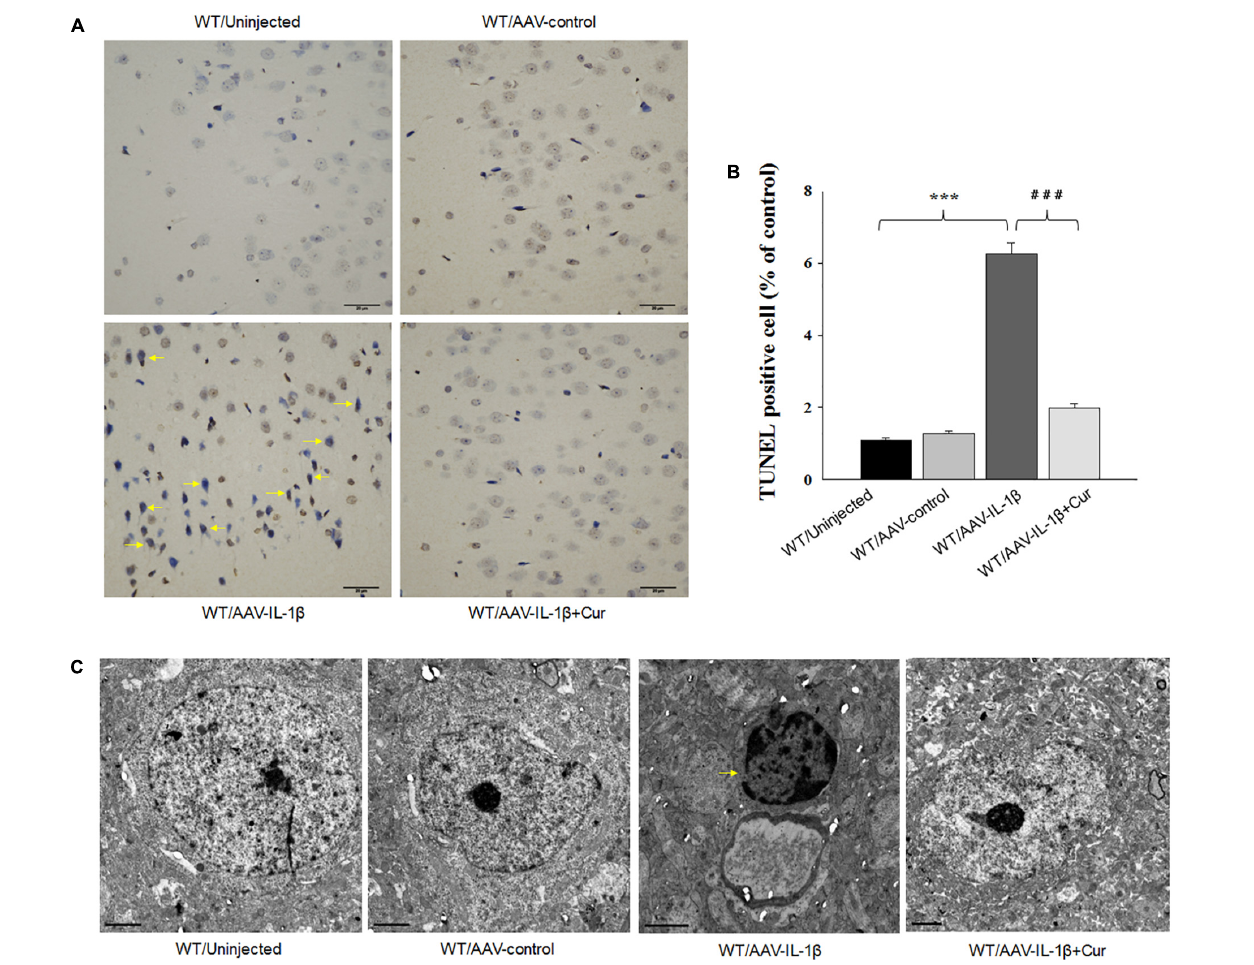
FIGURE 5 | Overexpression of IL-1 β within the vmPFC leads to neuronal apoptosis within the vmPFC of normal wild type rats. (A) TUNEL positive apoptotic cells (indicated by the arrows) in vmPFC regions infected with AAV-IL-1 β . (B) Histograms showing the increased TUNEL positive cells caused by AAV-IL-1 β infusion were significantly attenuated by curcumin treatment. (C) Nuclear chromatin abnormalities in vmPFC neurons infected with AAV-IL-1 β . Arrows indicate nuclear chromatin aggregation, condensation and margination. N = 6/group. ∗ P < 0.05, ∗∗ P < 0.01, ∗∗∗ P < 0.001 WT + AAV-IL-1 β vs. WT rats. # P < 0.05, ## P <